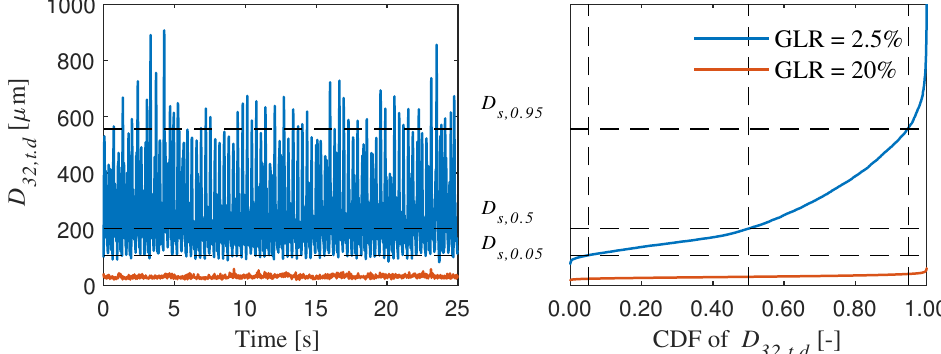
Figure 5. The drop sizes plotted vs. time ( left ) and converted into CDF ( right ) for the CFT nozzle spraying the less viscous